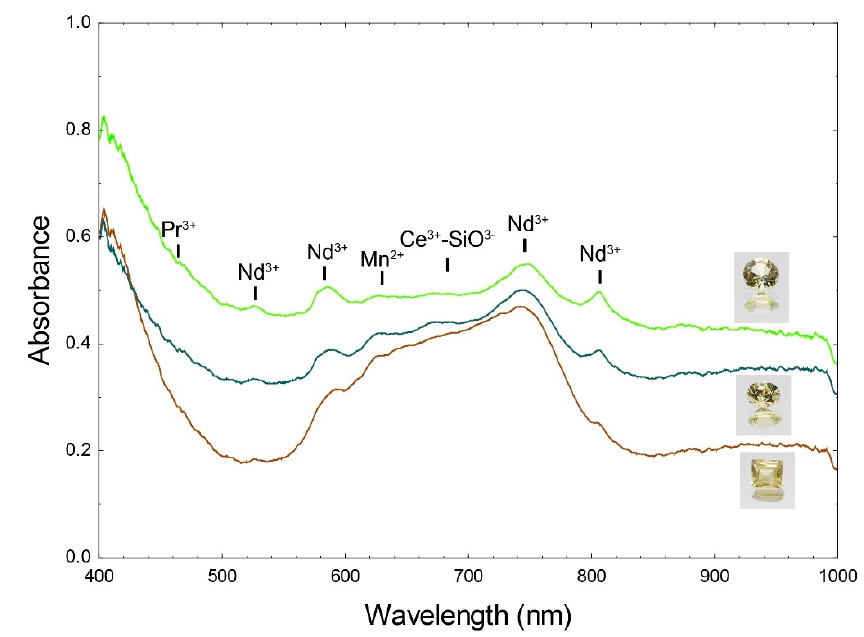
Figure 10. Optical absorption spectrum of hydroxylapatite cut stones from Muránska Dlhá Lúka. Table 7. The optical spectral bands (in nm) of the hydroxylapatite cut stones from Muránska Dlhá Lúka. Sample Assignment Process